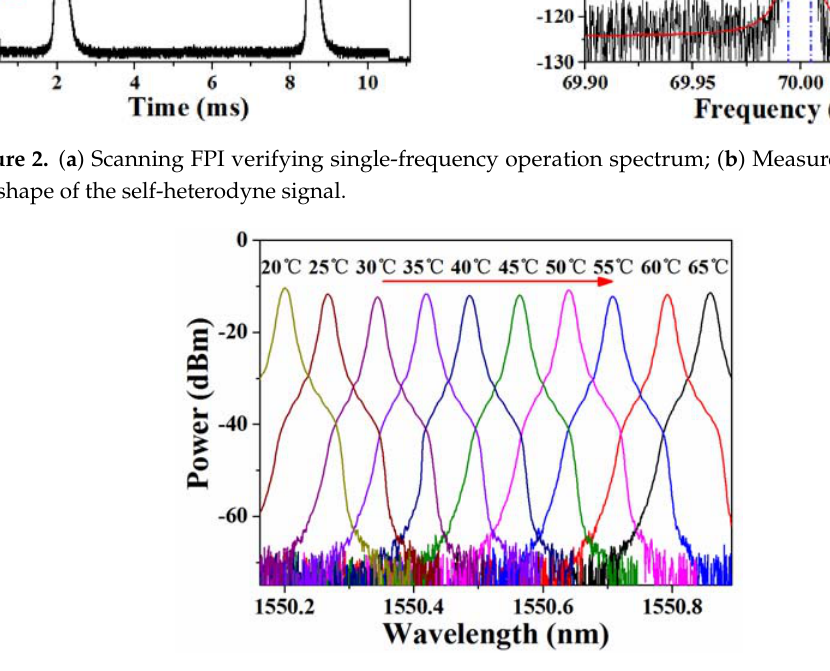
Figure 4. ( a ) Convolution of a narrow linewidth laser spectra translated to low frequencies; ( b ) Simulated heterodyne spectrum with a frequency shift of 10 kHz, corresponding to a temperature change of 5 × 10 − 6 °C.